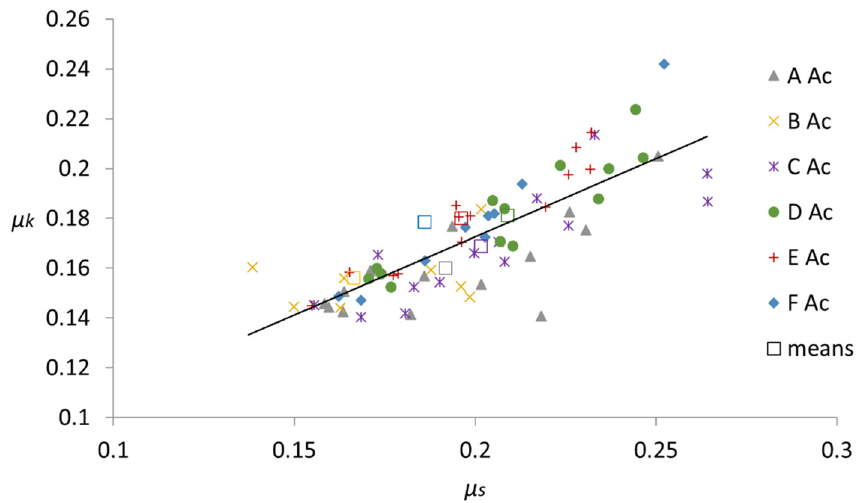
Figure 10. Relationship between the values of µ k and µ s for the different timber-to-steel friction pairs, as well as the mean value for each case (indicated by a square of the referred color) and the fitted line ( µ k = 0.65 µ s + 0.04).